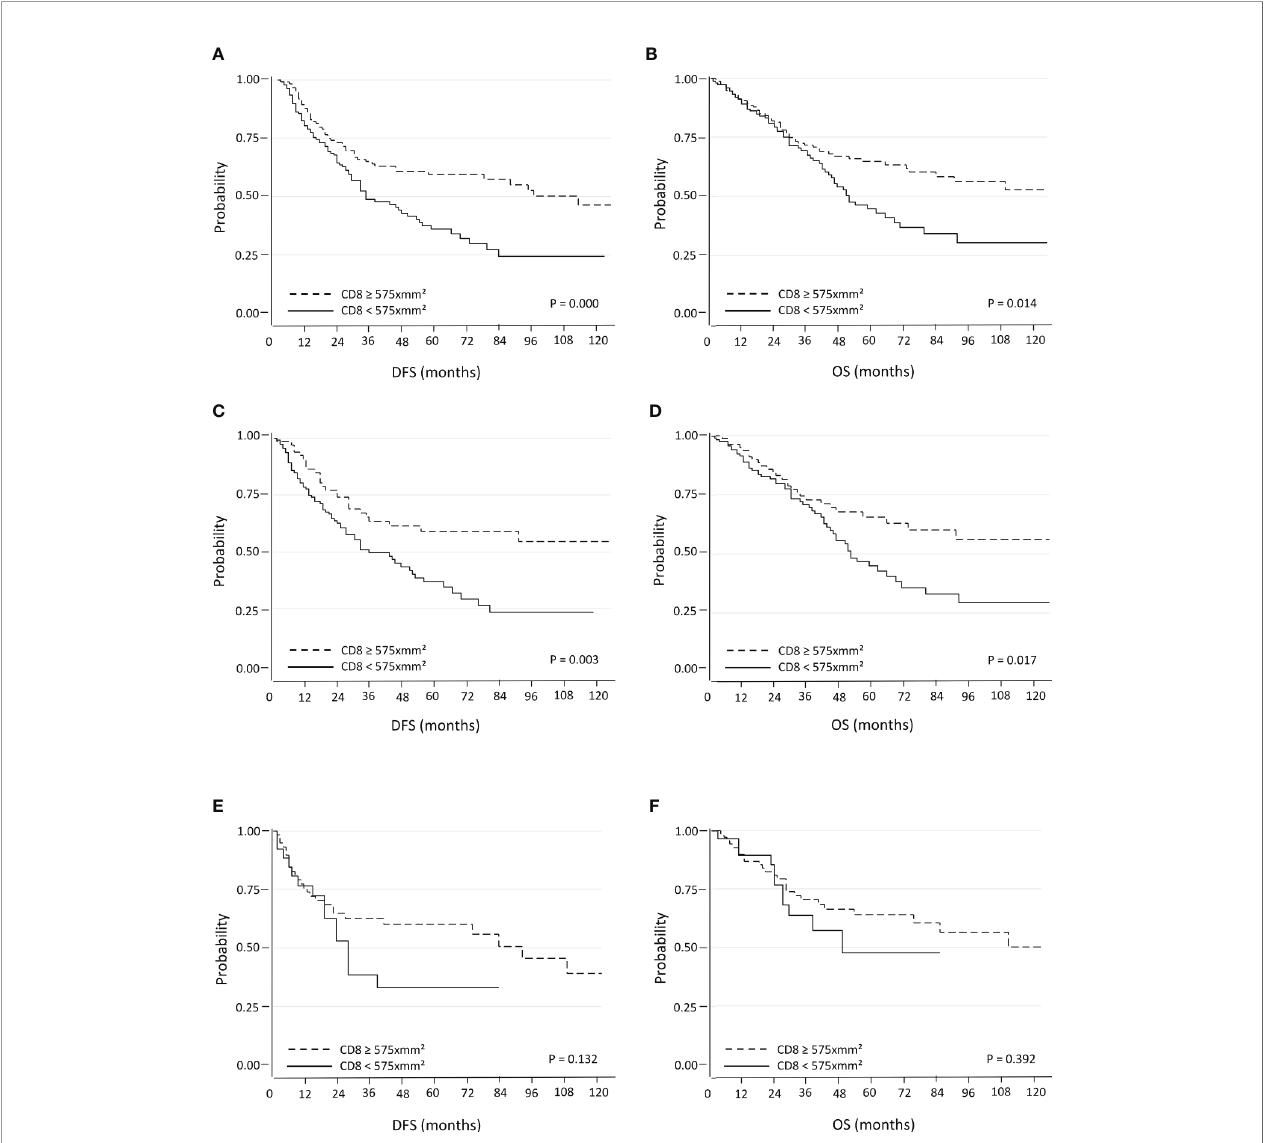
FIGURE 1 | Kaplan-Meier curves for DFS and OS based on CD8 + TILs using the median as the threshold in all (A, B) , in PD-L1 negative (C, D) and PD-L1 positive (E, F)